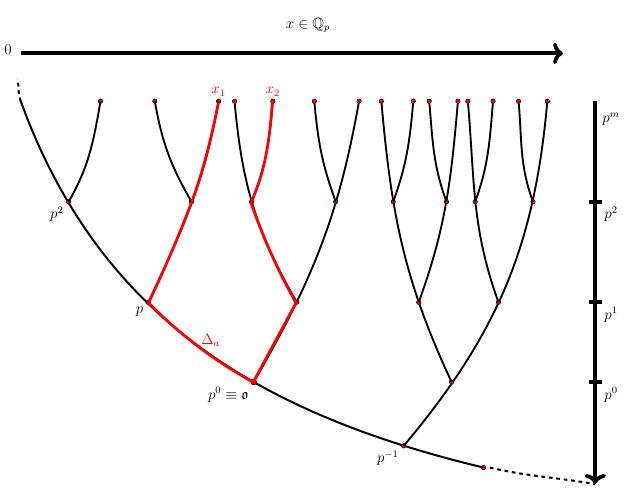
Figure 7. Computation of the 2-point function from the tensor